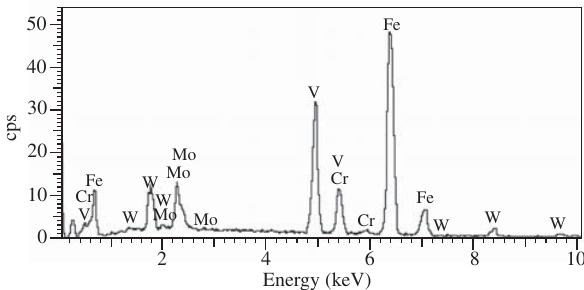
Figure 7. EDS microanalysis of MC type carbide.